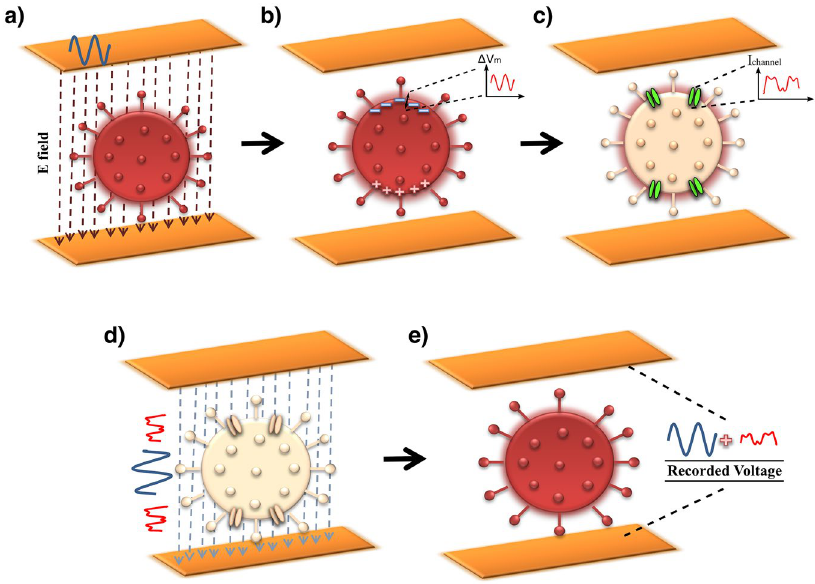
Figure 3. Schematic of a virus solution simulated by volume-conductor theory. ( a ) The sinusoidal voltage applied to the electrodes. ( b ) The SARS-CoV-2 viruses polarized along the field between the two electrodes. ( c ) The ion channels activated and generated nonlinear currents. ( d ) The linear and nonlinear parts of the current now flow through the solution. ( e ) Nonlinear currents are sensed at the electrode sites as a nonlinear voltage which ends up with adding odd harmonics to the power spectrum.